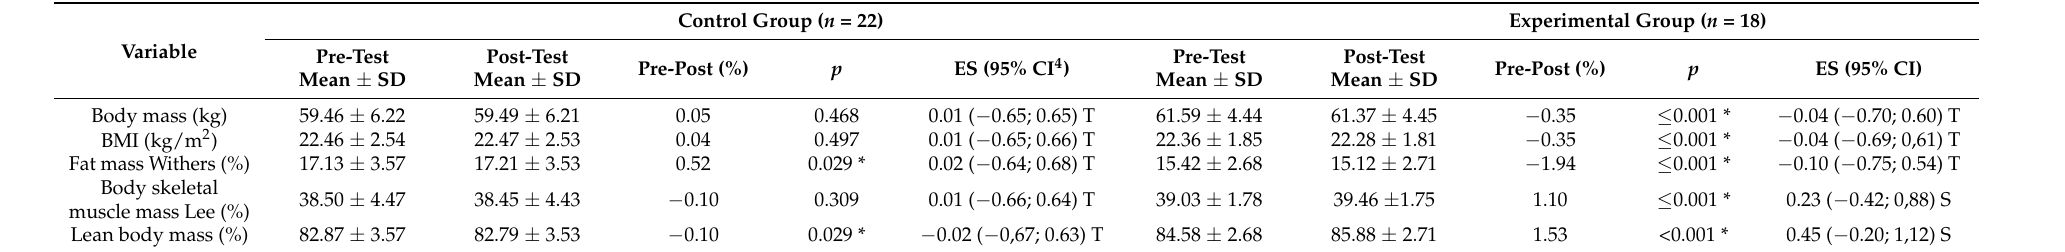
Table 5. Summary results of other body composition variables within the control group and neuromuscular training